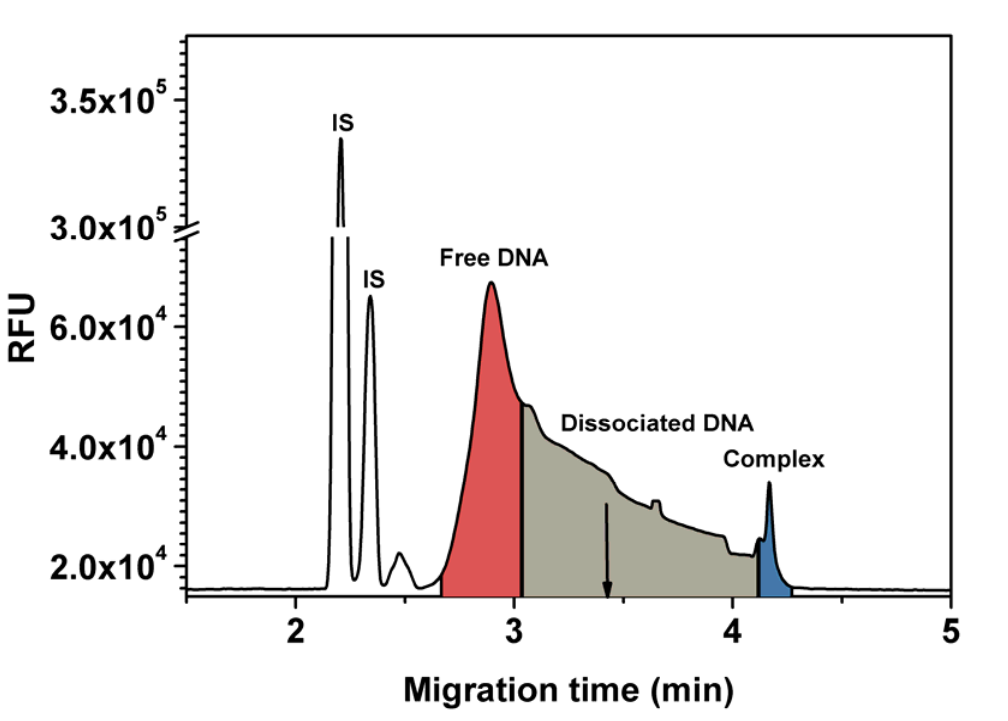
Figure 1. Choosing an aptamer collection window. The injection mixture contained 20 nM fluorescently labeled DNA and 1600 nM lysozyme. CE conditions: TGK buffer, pH = 8.3; 1psi/5s injection; 25 ºC; LIF detection; 40.2-cm, 50-µm-i.d. capillary; 20-kV